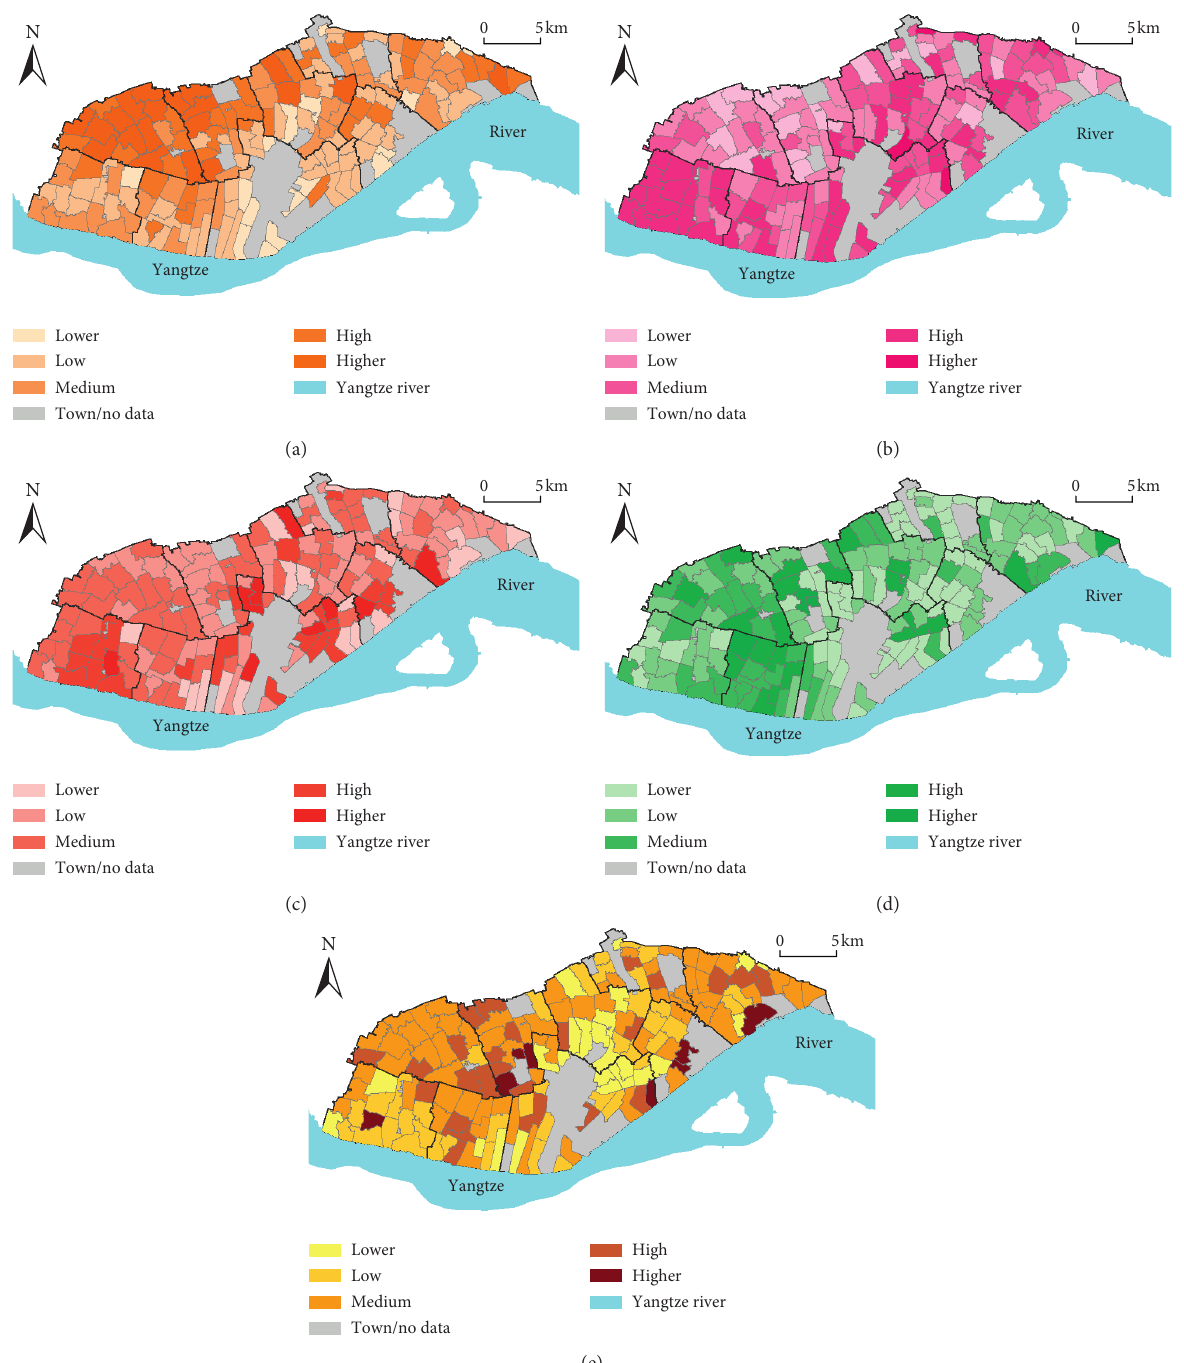
Figure 5: Spatial distribution of the rural function indexes in Jingjiang city in 2017: (a) APF, (b) NPF, (c) LF, (d) EEF, and (e)